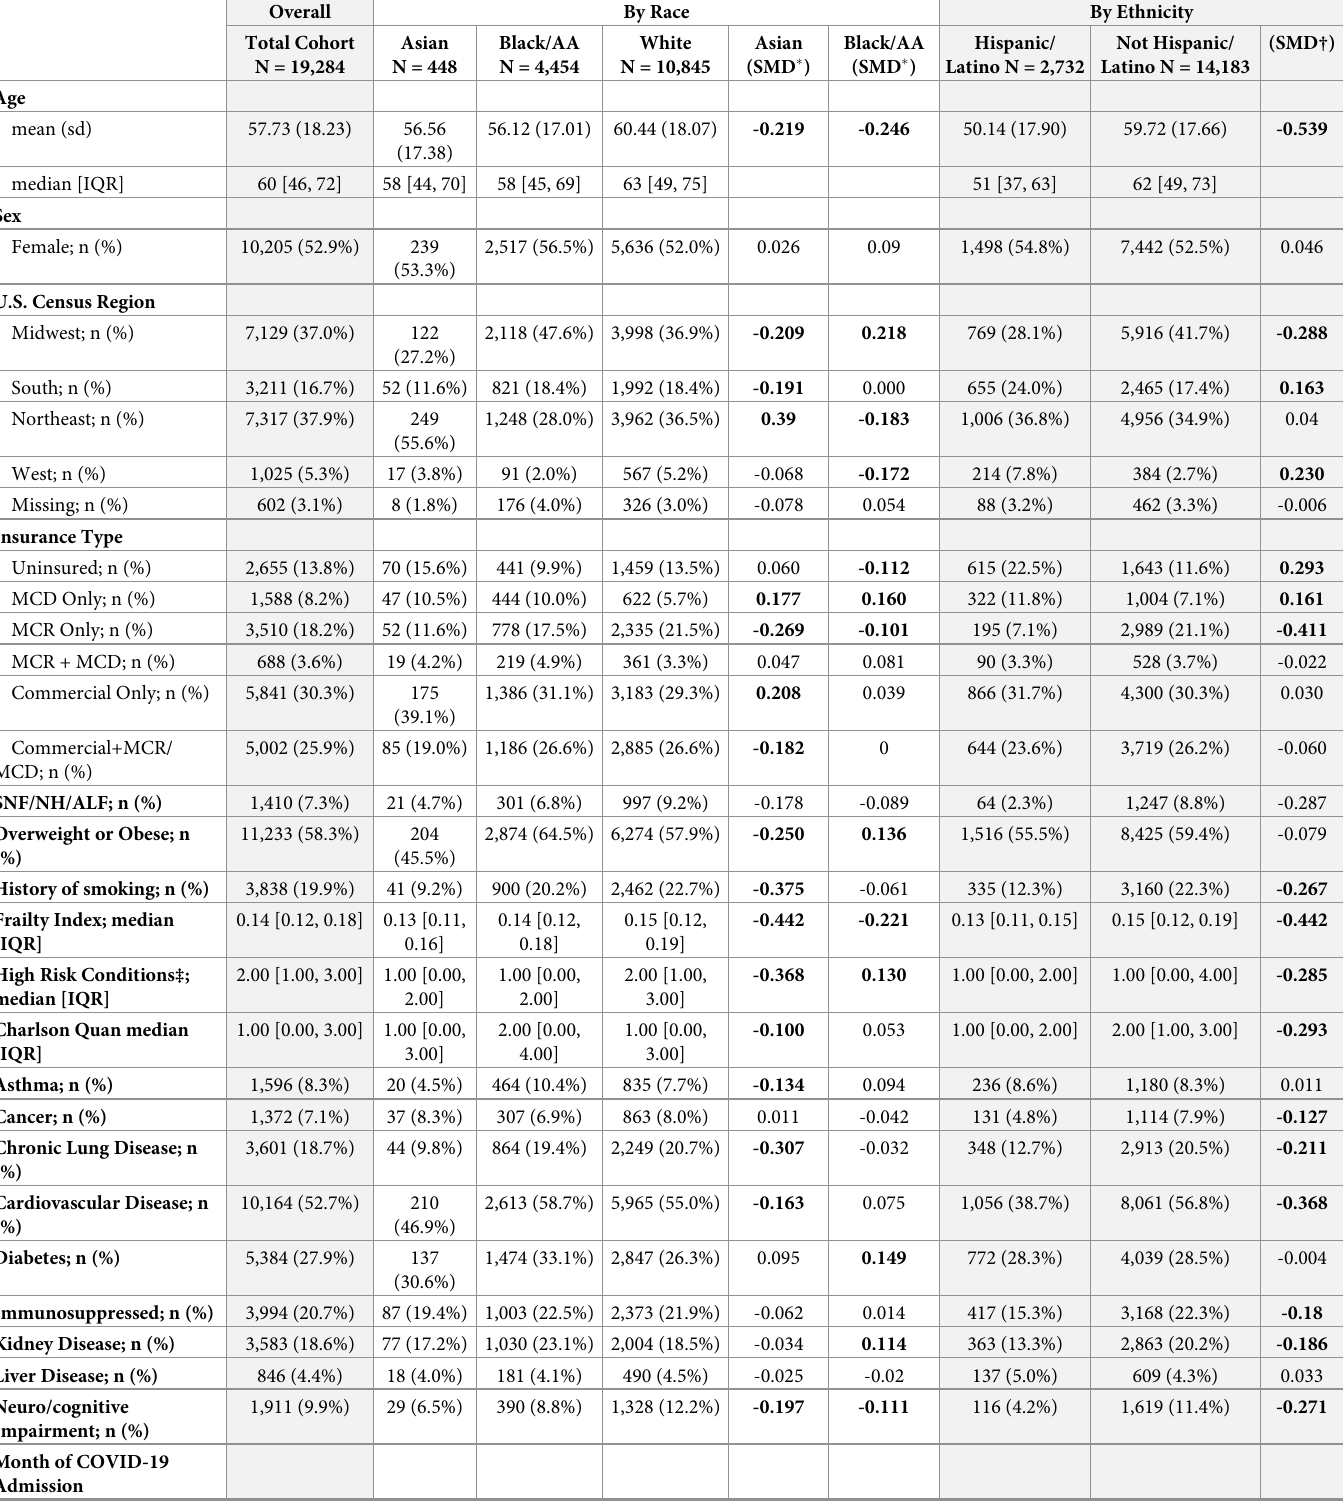
Table 1. Baseline and admitting characteristics by race, and by ethnicity.